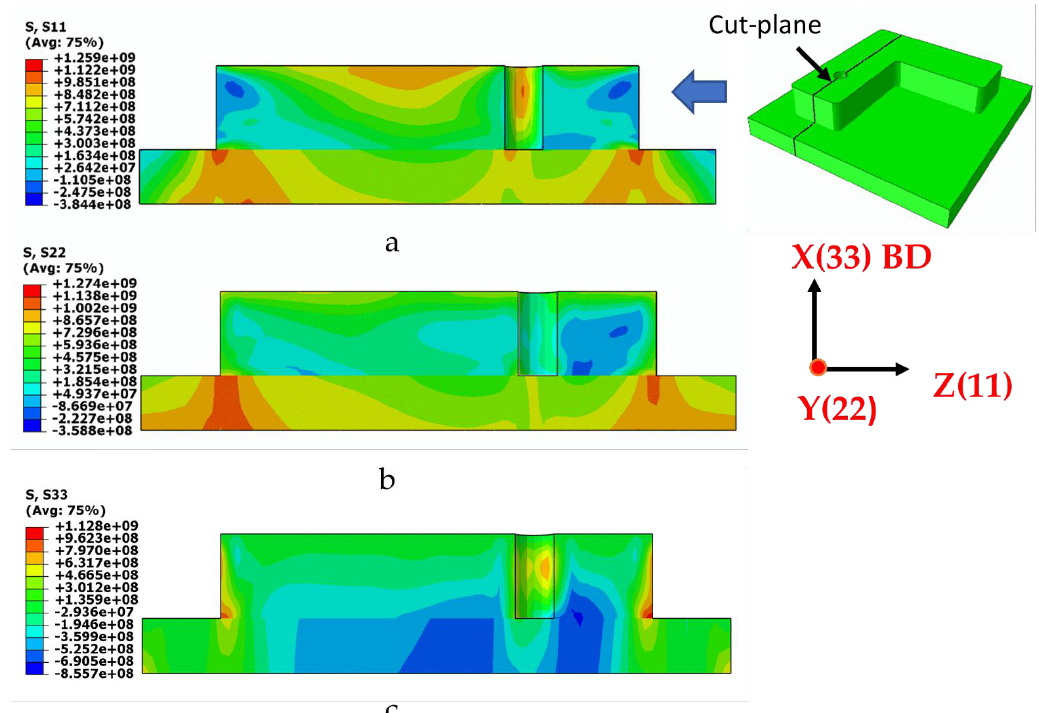
Figure 7. Cross-section view of the stress build up after the part is cooled to room temperature: ( a ) stresses in Z-direction, ( b ) stresses in Y-direction, ( c ) stresses in X -direction (building direction). (Note: stresses are in [Pa].).